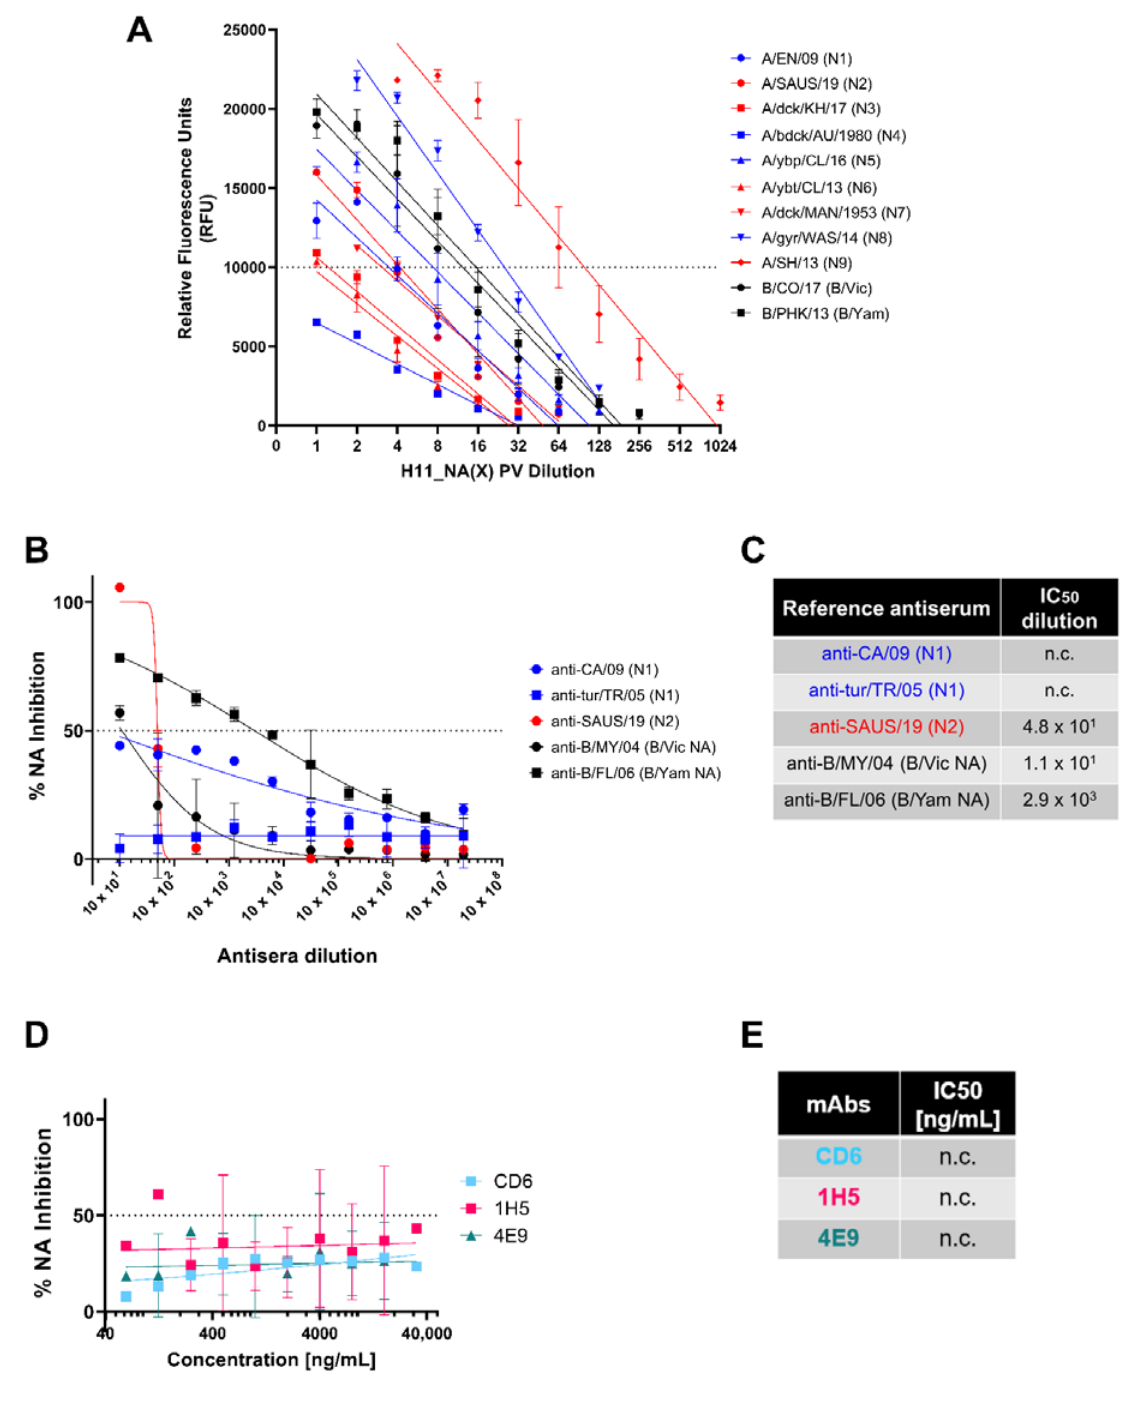
Figure 5. Determination of NA activity of H11_NA pseudotypes and NA inhibition activity of reference antisera and mAbs via NA Fluor™. ( A ) Titration of representative IAV (N1-N9) and IBV (B/Victoria-like and B/Yamagata-like lineages) PV. Titers are reported in relative fluorescence units (RFU) (n = 2). Dotted line at 10,000 RFU indicates value used for NA activity normalization (Figure S2). ( B , C ) Inhibition of A/England/195/09 (N1) (blue), A/South Australia/34/19 (N2) (red), IBV (black) B/Colorado/6/17 (B/Vic NA) and B/Phuket/3073/13 (B/Yam NA) H11_NA PV